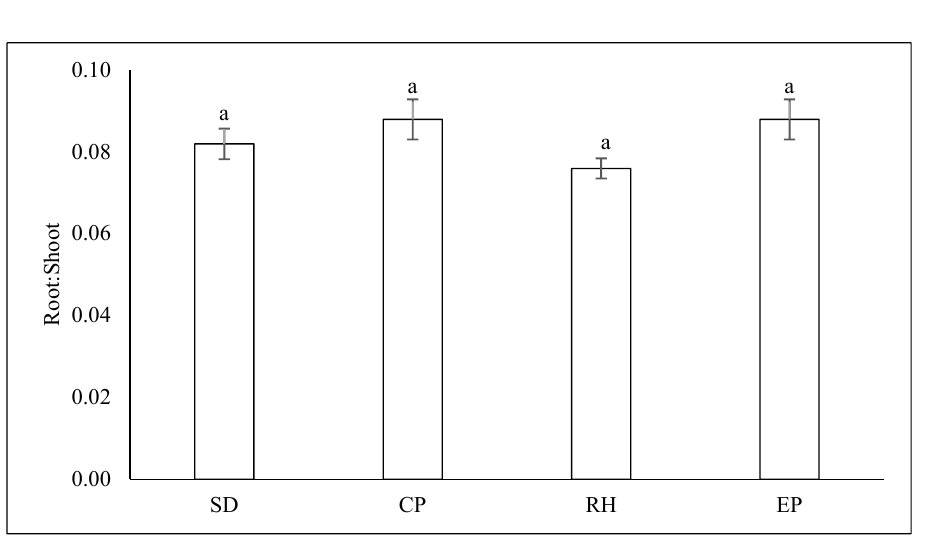
Abbreviations are as follows for substrate mixtures of cocopeat: sawdust: rice husk in the following proportions: 1:3:1 (SD sawdust); 3:1:1 (CP cocopeat); 1:1:3 (RH rice husk); and 1:1:1 (EP equal proportions of all three organic